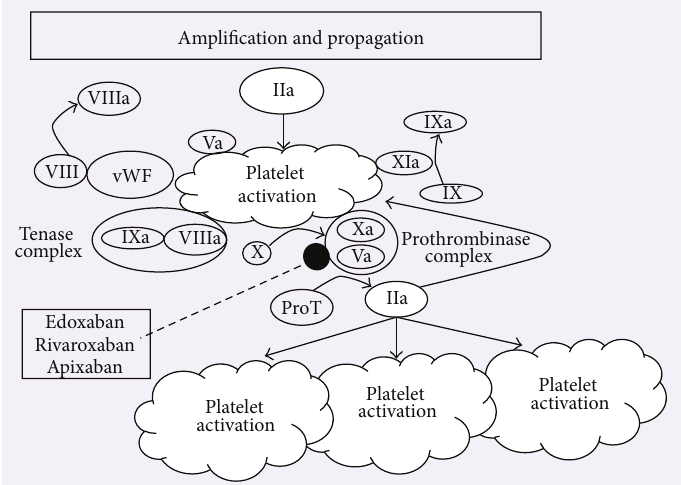
Figure 2: Adapted with permission: Zalpour and Oo [8]. Abbreviations: TF, tissue factor; VII, factor VII; VIIa, activated factor VII; X, factor